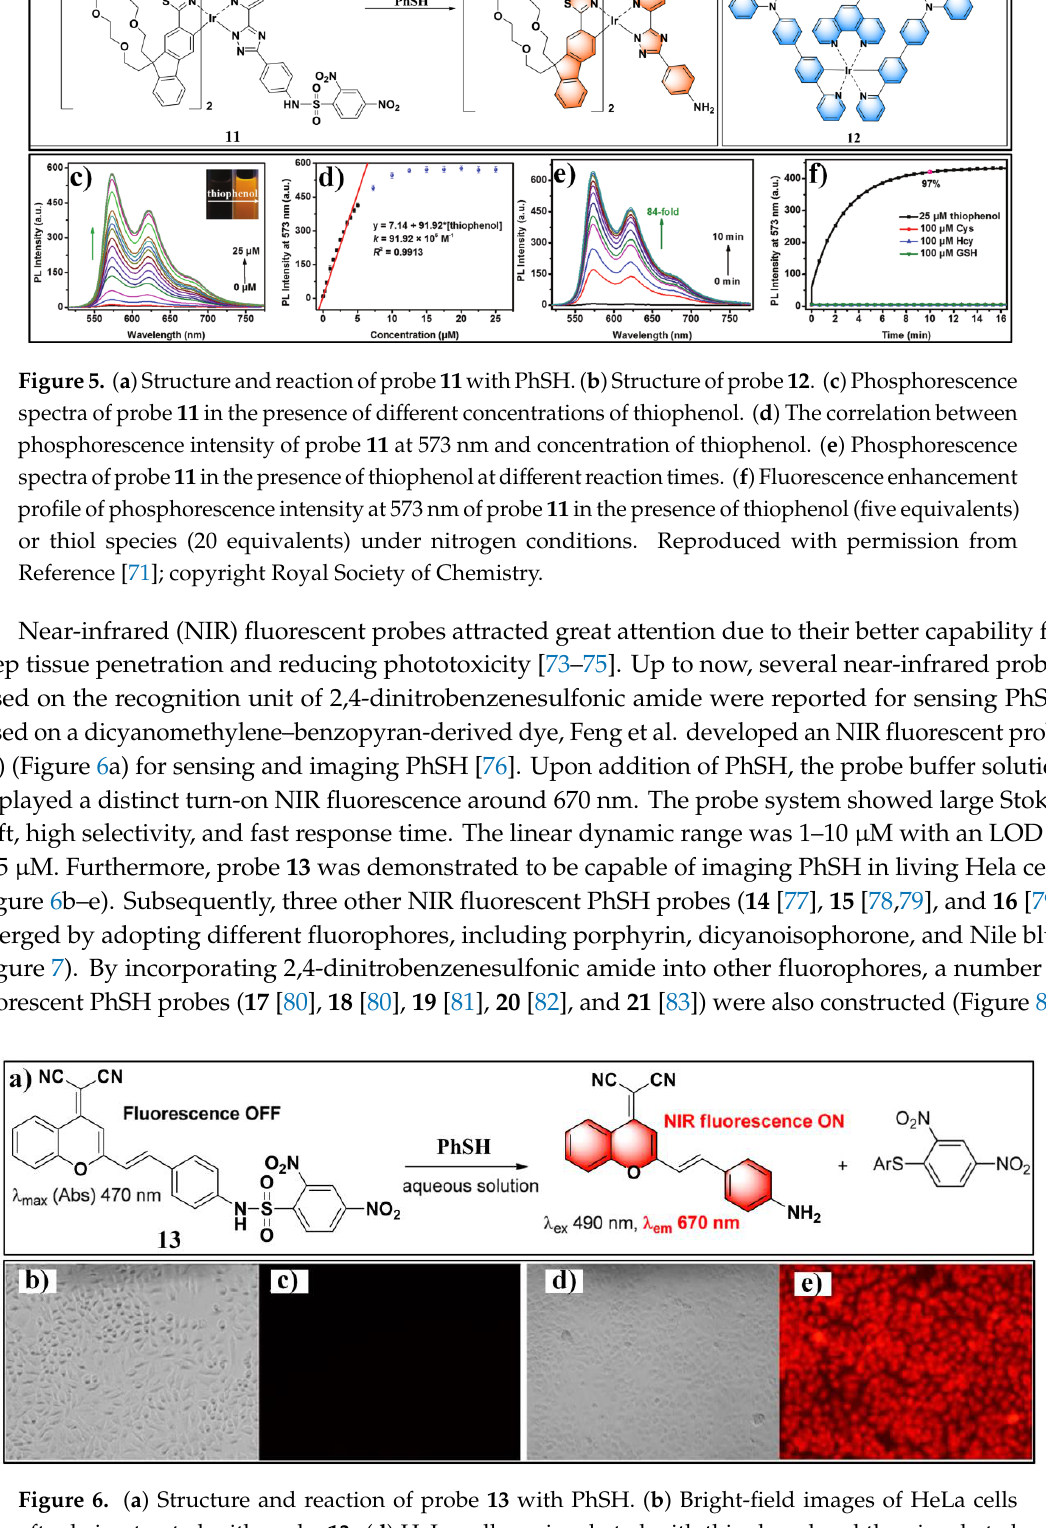
Figure 6. ( a ) Structure and reaction of probe 13 with PhSH. ( b ) Bright-field images of HeLa cells after being treated with probe 13 . ( d ) HeLa cells preincubated with thiophenol and then incubated with probe 13 . ( c , e ) Fluorescence images of ( b , d ), respectively. Reproduced with permission from Reference [76]; copyright American Chemical